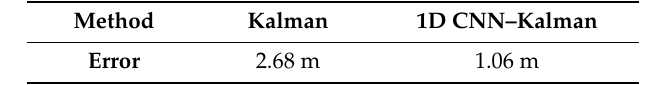
Table 1. Comparison of the end point positioning error in an indoor track 1